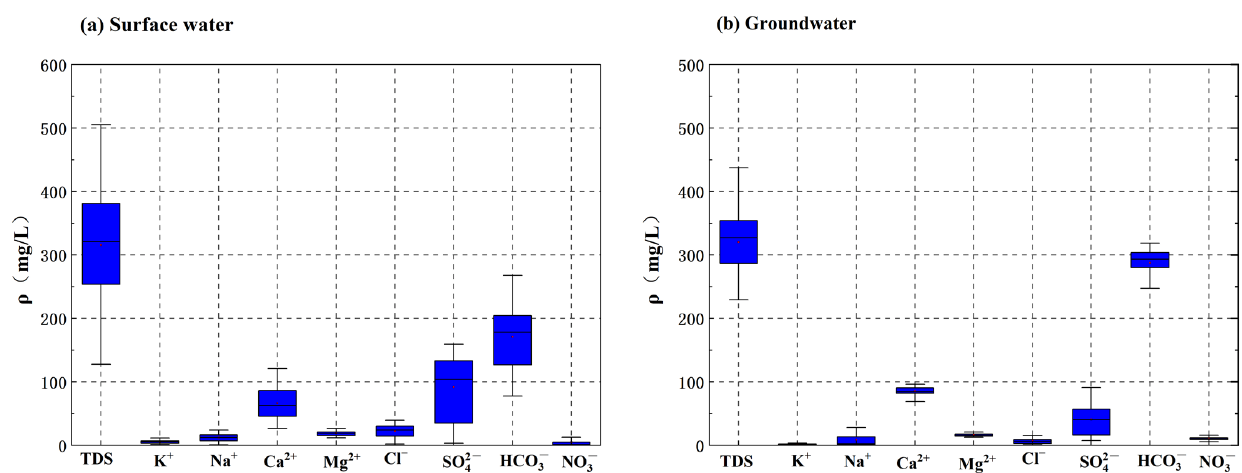
Figure 2. Statistical characteristics of surface water ( a ) and groundwater ( b ) major ions in NKWS.